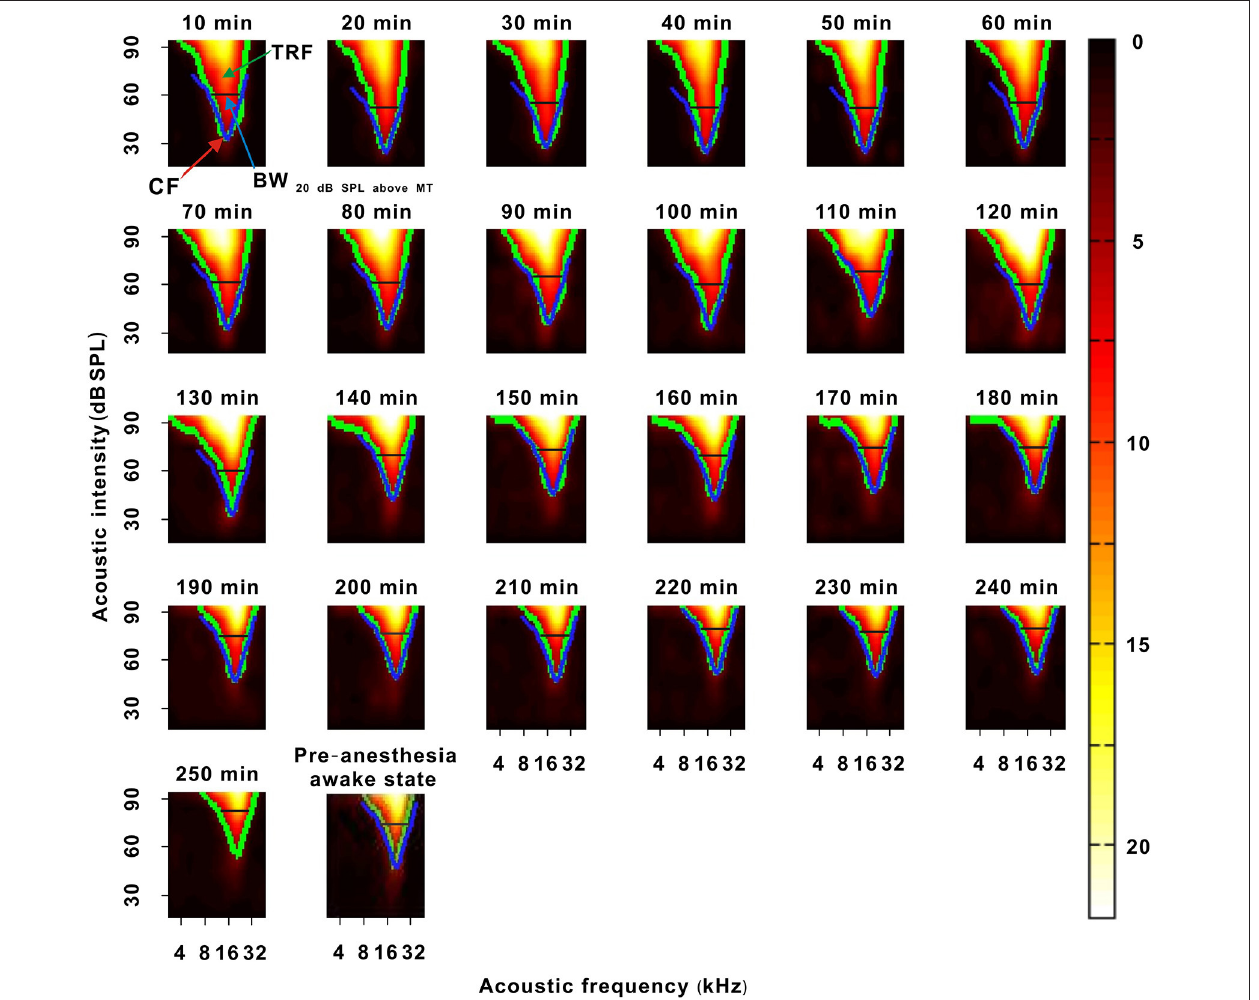
FIGURE 6 | A representative neuron with a change in the TRF. The 10–250min was the time after urethane anesthesia. Each green curve was the contour of the TRF. The blue curve showed the contour of the TRF in the last recording session. The width of the black transverse line was BW 20 dB SPL above MT in the last recording session. The red arrow labeled the location of CF. The last pseudocolor map on the bottom was obtained under the pre-anesthesia awake